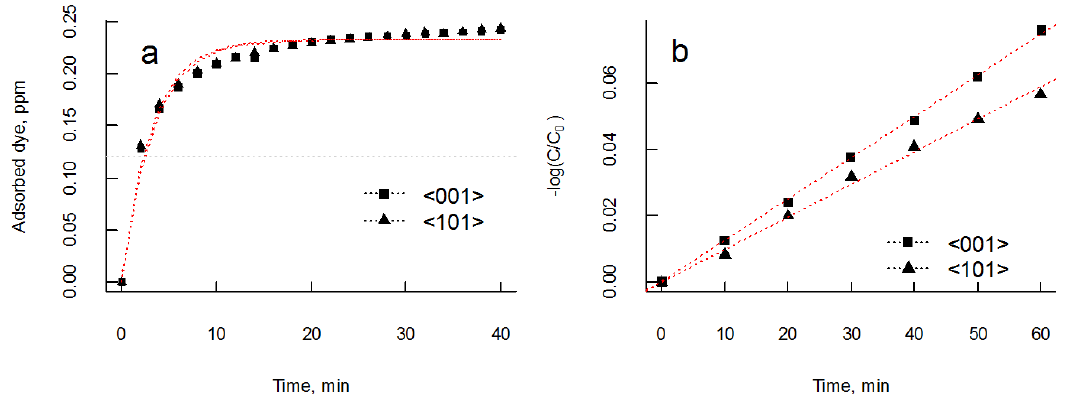
Figure 6. ( a ) Adsorption of methylene blue dye as a function of time, and ( b ) semi-logarithmic plot of the normalized MB concentration, C , as a function of UV irradiation time over <001> and <101> TiO films. The gray line denotes the amount of dye adsorbed by 2 reaction cell walls and uncoated glass slide in blank